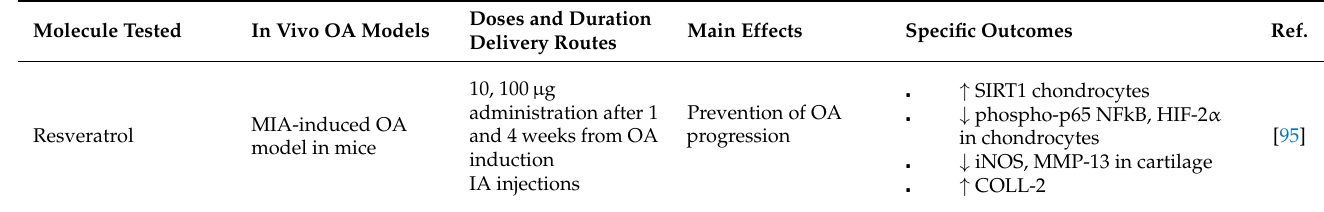
Table 2. PPs effects on inflammation and pain: in vivo models of OA. Doses and Duration Molecule Tested In Vivo OA Models Main Effects Specific Outcomes Ref. Delivery Routes